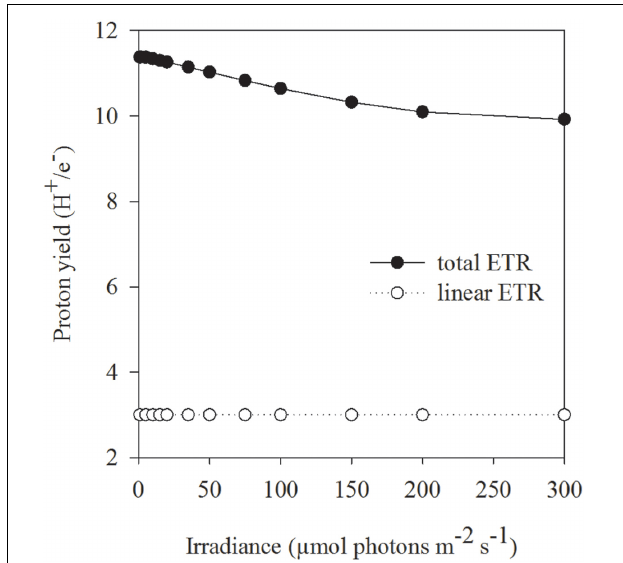
FIGURE 6 | The effect of linear electron transport (open circles) as well as in combination with plastid plastoquinol terminal oxidase (PTOX) activity (filled circles) on the proton yield (H + /e − ratio) was calculated by the example of ML acclimated C. debilis cells under control conditions. Theoretical simulations are based on the model of Kroon and Thoms (2006), which was adapted to the diatom C. debilis , and the adapted model parameters therein are given in Supplementary Table S2